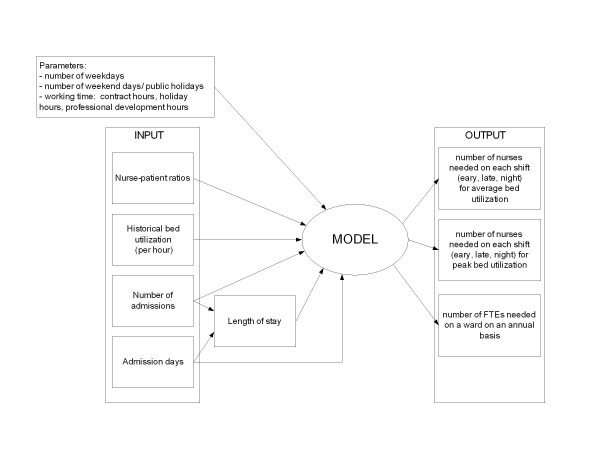
Outline of model.